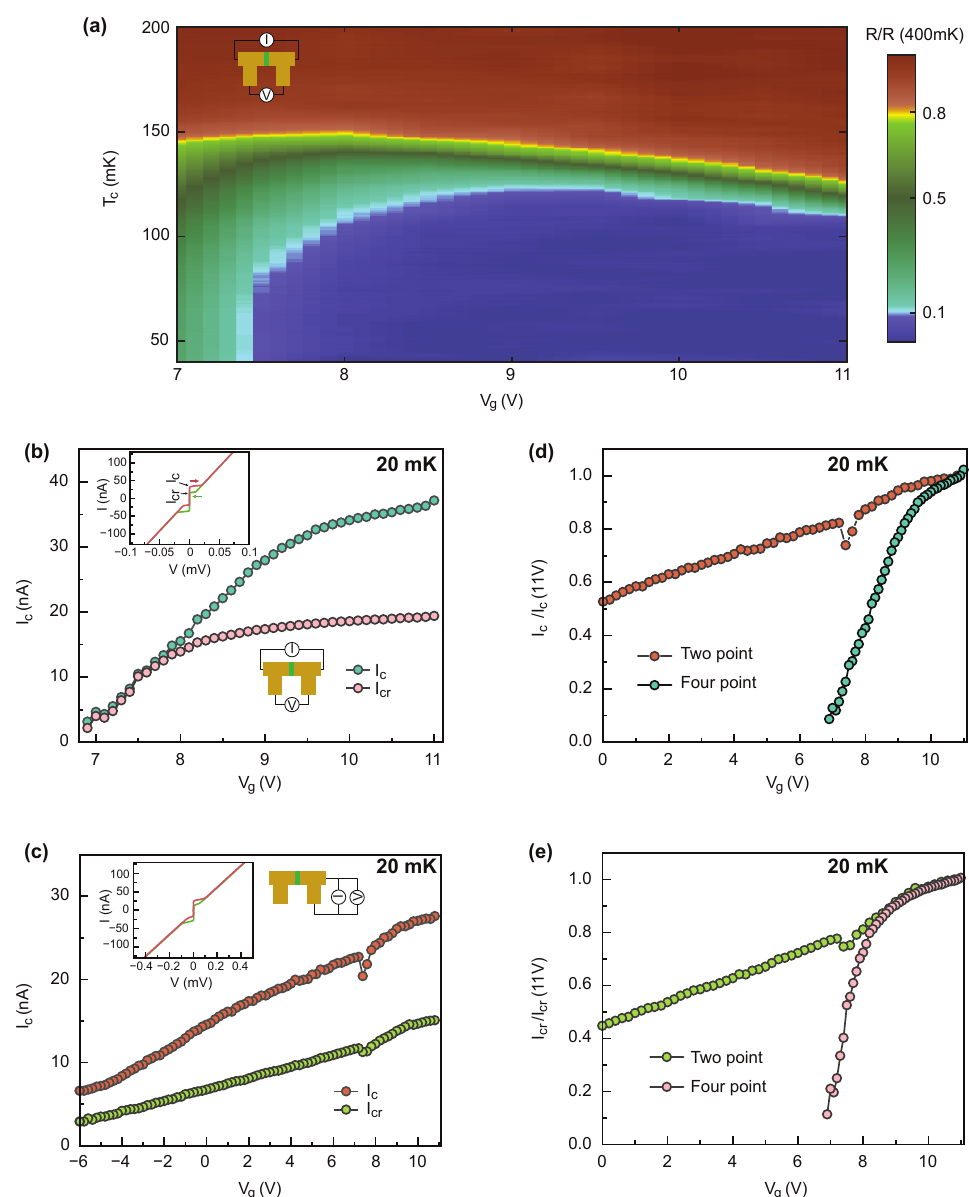
Figure 5. Superconducting properties of weak link devices. ( a ) Color plot of a resistance of the weak link device with barrier width 30 nm as a function of temperature and gate voltage. The resistance is normalized to the resistance at 400 mK. ( b ) The + − + − c − I c cr − I cr evolution of average critical current ( I c = I ) and average return current ( I cr = I ) as a function of gate voltage for 2 2 the weak link device measured in four-probe configuration. The I c and I cr are identified as switching current, in I–V curves, to normal state in forward bias, and returning current to superconducting state respectively. Inset shows the I–V curve of the device measured at 11 V. ( c ) The gate voltage dependent I c and I cr for the uniform device measured in two point configuration. Inset shows the I–V curve of the device at 11 V. The comparison of normalized average critical current ( d ) and normalized average returning current ( e ) as a function of gate